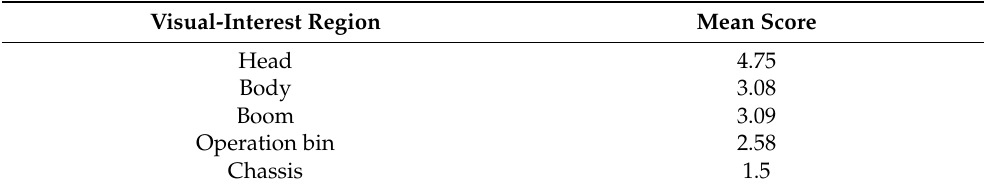
Table 5. The mean score of each visual-interest region.